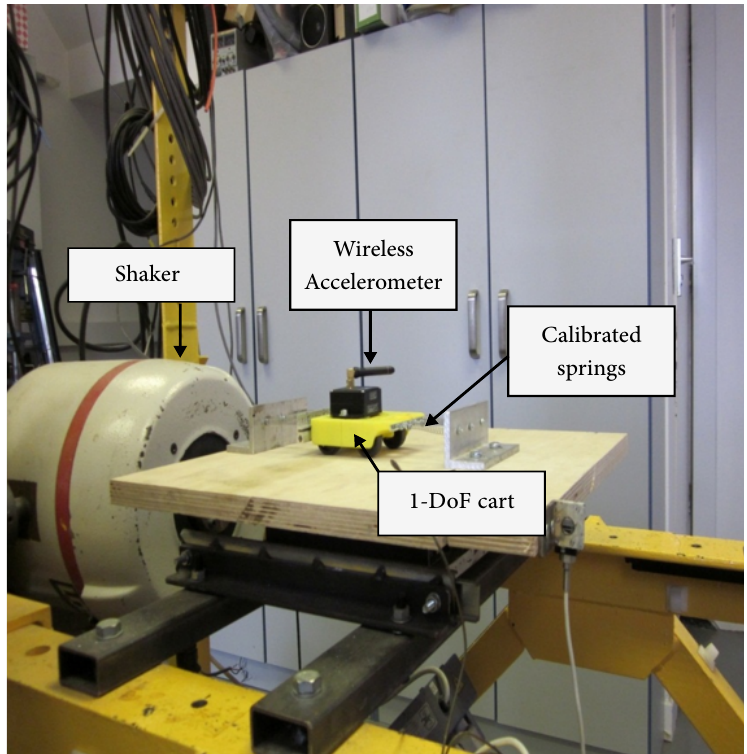
Figure 3. Setup for experimental test. The base on which the cart is placed was excited by Gaussian white noise by the shaker shown to the left. A total of 6 calibrated springs (3 on each side) are attached to the cart. The stiffness was changed in the damaged condition by removing 1 spring from each